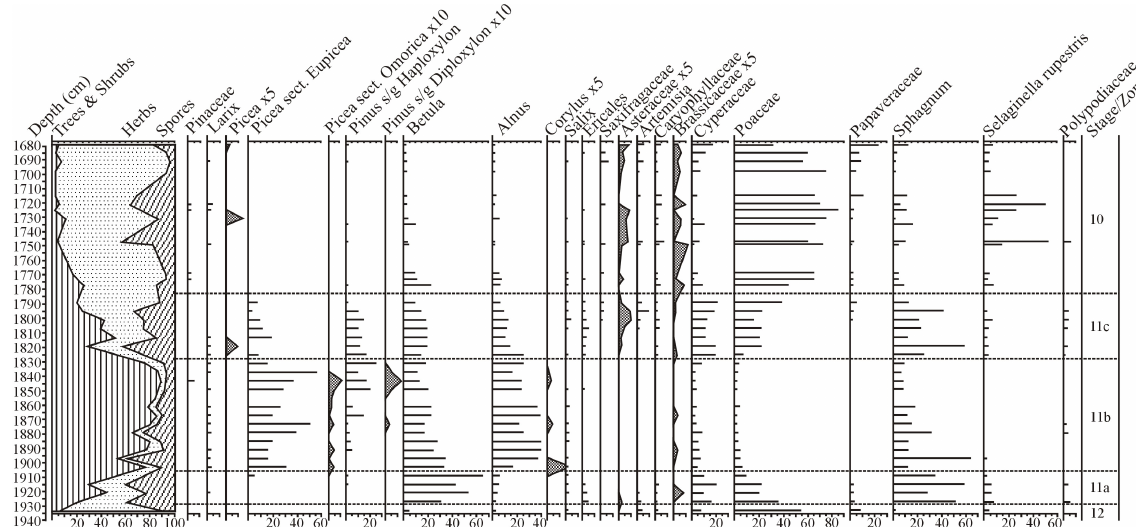
Fig. 3. Percentage diagram of select taxa from MIS10 to MIS12. The climatic optimum is represented by zone 11b. Results are from core ICDP